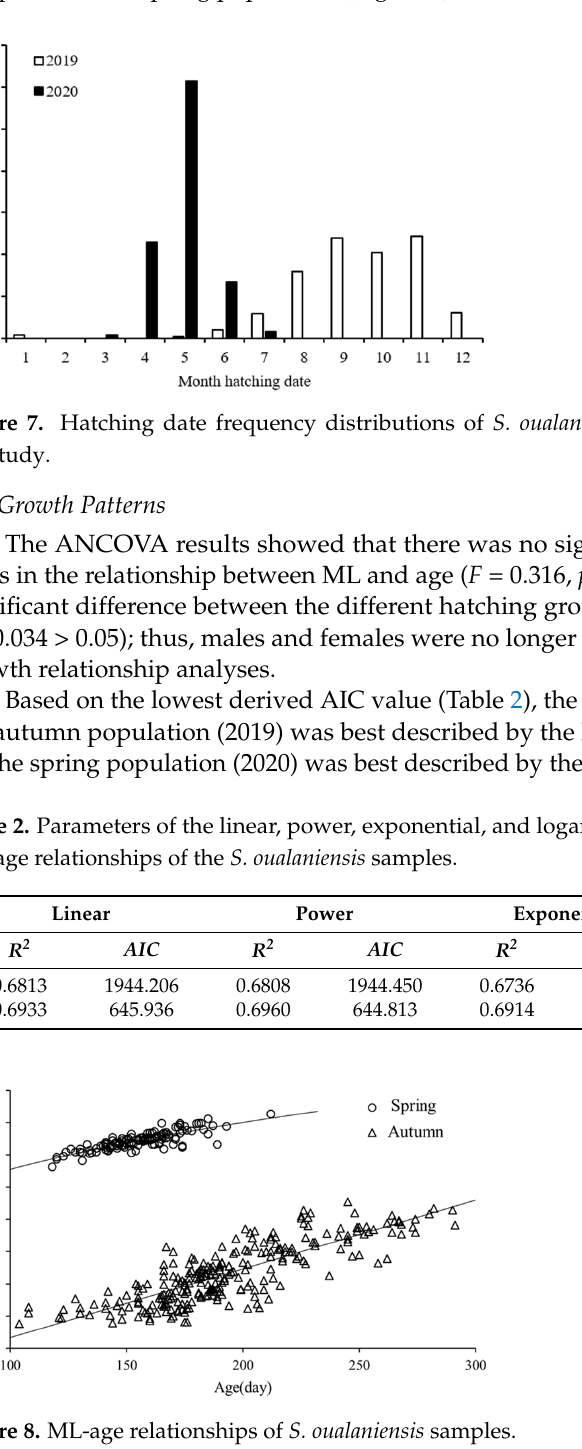
( b ) Figure 9. Relationships between the ML growth rate and age of S. oualaniensis samples: ( a ) IGR; ( b ) AGR. 4. Discussion 4.1. ML and BW Distributions The results showed that compositional differences existed in the ML and BW data between the two years of study, with the largest differences observed among females. Both the ML range and majority ML group of the S. oualaniensis samples collected in 2020 were heavier than the corresponding values of the specimens collected in 2019. According to the ML size and morphological structure at sexual maturity, S. oualaniensis populations can be divided into four groups: large-squid populations (with ML ranging from 400–500 mm), which are mainly distributed in the Indian Ocean and Arabian Sea [30]; medium- squid groups (with ML ranging from 190~250 mm), which are widely distributed [15]; small groups (with ML ranging from 120~160 mm), which are also found in the Indian Ocean [31]; and microgroups (with ML ranging from 90~120 mm), which occur in the eastern Pacific Ocean near the equator [3]. The analysis performed herein showed that the samples collected in 2019 were composed of medium- and small-squid populations, while